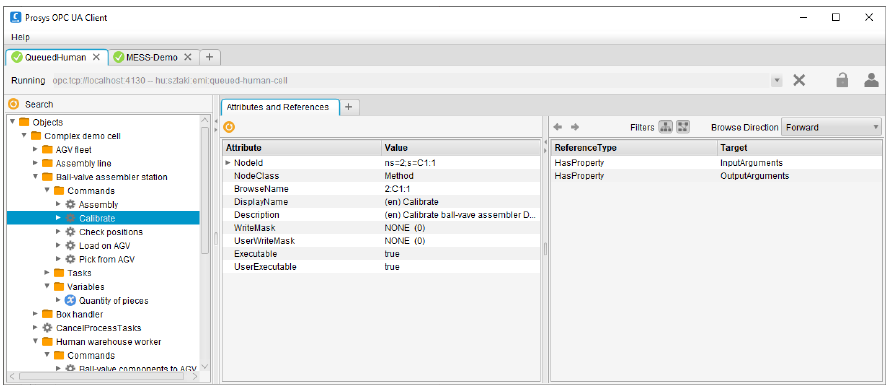
Figure 5. View of Twinned CPS instance via a commercial OPC UA client